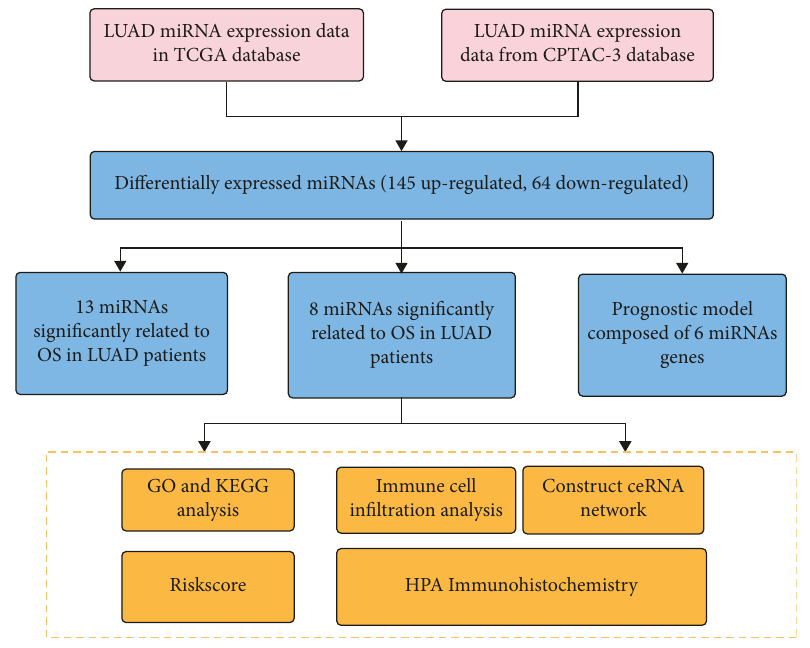
Figure 1: Schematic of prognostic model workflow for the overall survival of six